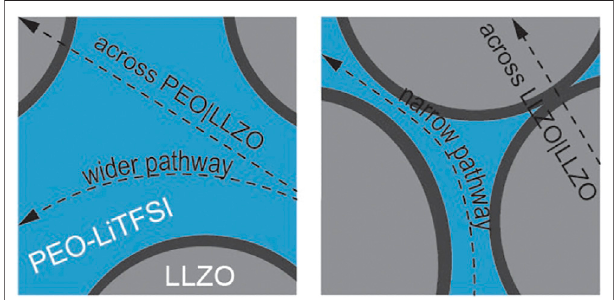
FIGURE 1 | Schematics of Li-ion pathways in PEO-LiTFSI with 10 wt% (left) and 20 wt% (right) LLZO fi ller content. The Li-ion pathways are wider when the fi ller content is low, thus enabling fast Li-ion transport. At higher fi ller content,theLi-ionpathwaysbecomenarrowandtheresistanceatPEO- LiTFSI/LLZOinterfaceistoohigh,whichblockstheLi-iontransportandresults in low Li-ion conductivity of the CE.